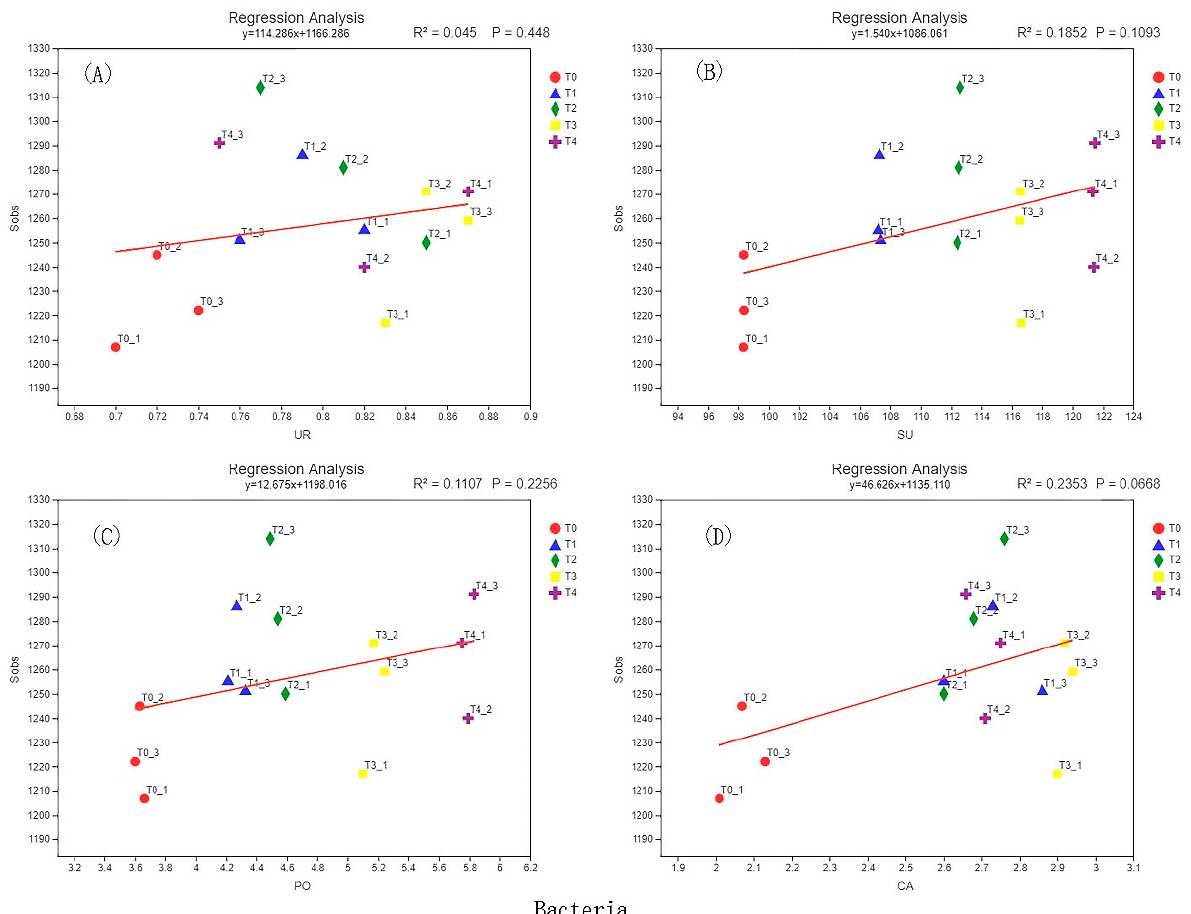
Figure 4. Regression analysis of bacterial ranking. The X-axis is the environmental factor, the Y-axis is the α -diversity ranking axis, and R 2 is the coefficient of determination, which represents the proportion of variation explained by the regression line. The larger the R 2 value, which indicates that the environmental factor shows differences in the community composition or α -diversity of the sample on the ranking axis, the higher is the degree of explanation of the difference in the diversity index. ( A ) The environmental factor is urease (UR); ( B ) the environmental factor is sucrase (SU); ( C ) the environmental factor is polyphenol oxidase (PO); ( D ) the environmental factor is catalase (CA). 3.7. Correlation Analysis of Soil Microbial Biomass Carbon and Nitrogen and Microbial Diversity Soil MBC, MBN, TOC, TN, MBC/TOC, and MBN/TN had positive effects on soil microbial diversity (Figures 6 and 7). The coefficient of influence (R 2 ) of MBN on bacterial diversity was the highest, 0.3553; the second highest was that of TOC, 0.3553. The coeffi- cients of influence of TN, MBC, MBC/TOC, and MBN/TN on soil bacteria were 0.2568, 0.2341, 0.0156, and 0.2132, respectively (Figure 6). MBC, MBN, TOC, TN, MBC/TOC, and MBN/TN also had positive impacts on soil fungal diversity, but overall, the above indica- tors had a lower impact on soil fungal diversity than on soil bacterial diversity (Figure 6). The coefficient of influence of MBC on fungal diversity was the highest, 0.18; the second highest was that of MBN/TN, 0.0958. The coefficients of influence of TOC, TN, MBN, and MBC/TOC on soil fungi (R 2 ) were 0.0775, 0.0824, 0.0285, and 0.0428, respectively (Figure